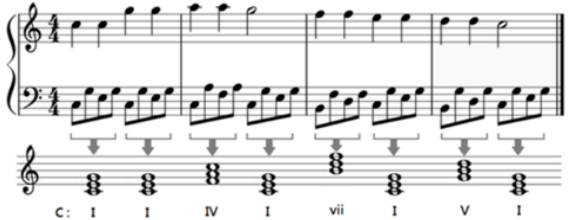
Figure 2. The chord mapping in the first four-measures of 12 Variations on “Ah, vous dirai-je, Maman” by Mozart.